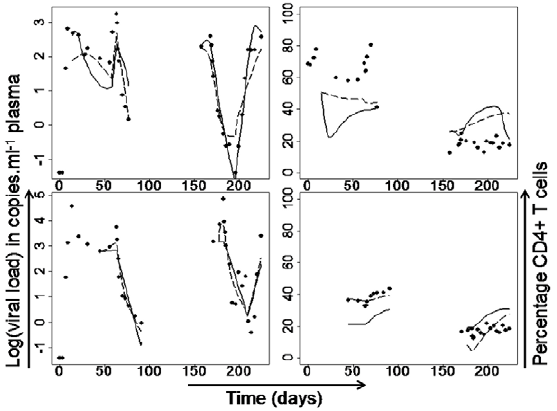
Figure 4. Experimental data and model fits. Experimental viral load and percentage CD4 + T cells (filled dots on left column and right column respectively) and the best fitting non-lytic model (non-lytic model ii; solid lines) and the best-fitting lytic model (lytic model i; dashed lines). Number of parameters: 10 and 8 respectively. Model selection was based in the AIC c , which is adjusted for differences in number of parameters. This figure shows representative data and fits, the full set can be found in Figure S6 in Text S1. Please note that for animals in Group B data for CD4 + and CD8 + T cells was only available from 45 days after infection, hence viral load data before this time point have not been fitted.